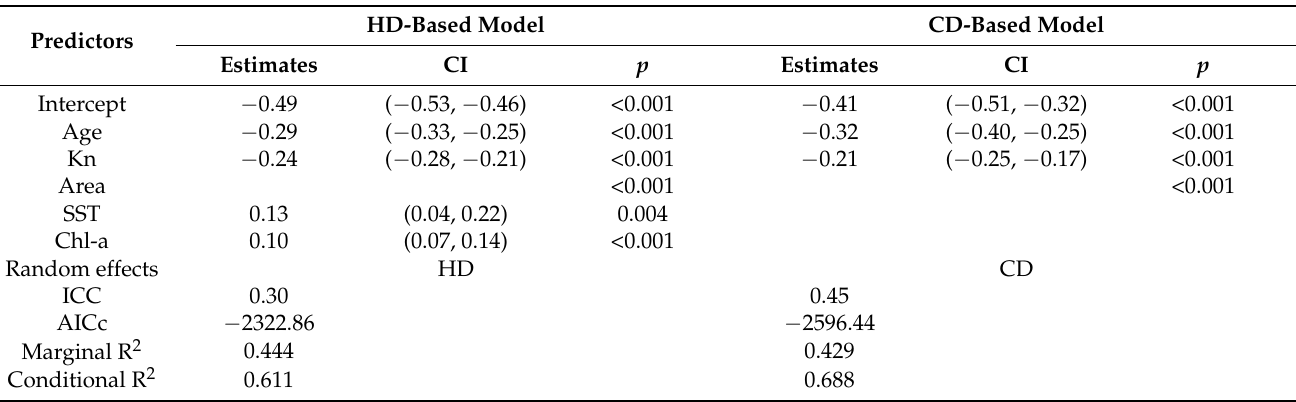
Table 3. Parameter estimates (with CI and p) for the HD-based and CD-based model describing variation in mean daily growth rate of larval and juvenile Japanese anchovy off the Pacific coast of Japan in